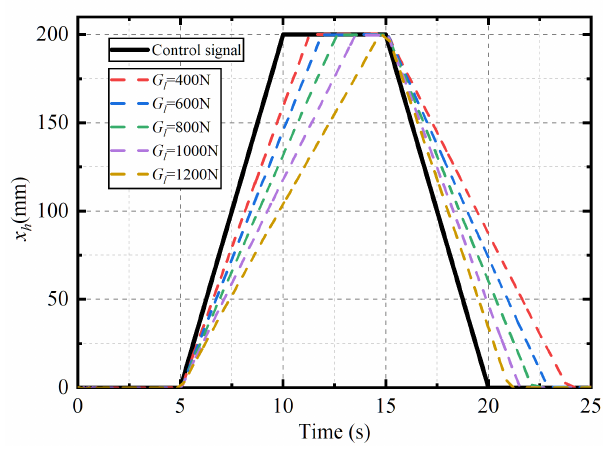
Figure 20. Displacement output, x h , at different gravity of load mass, G l , when depth is 11 km.